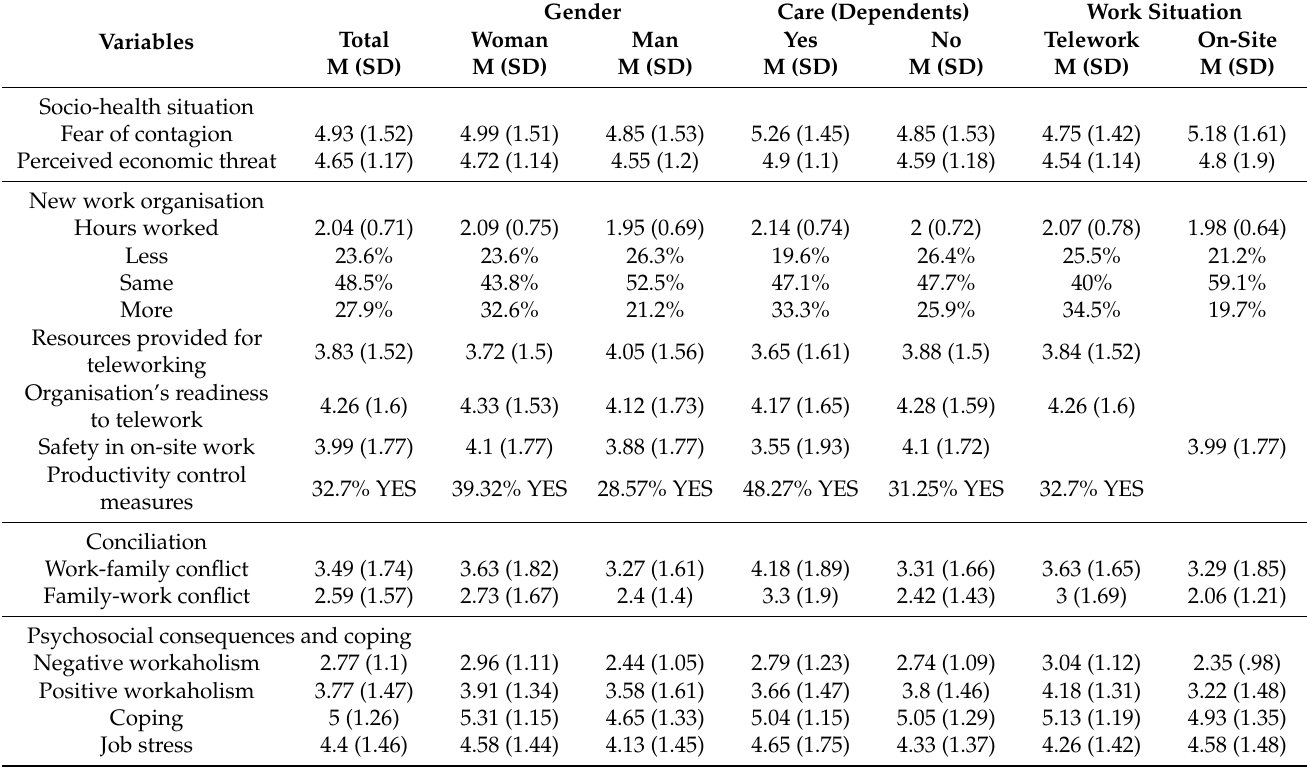
Table 5. Descriptive statistics for study variables in Study 2, by gender, care (having dependents or not), and work situation.